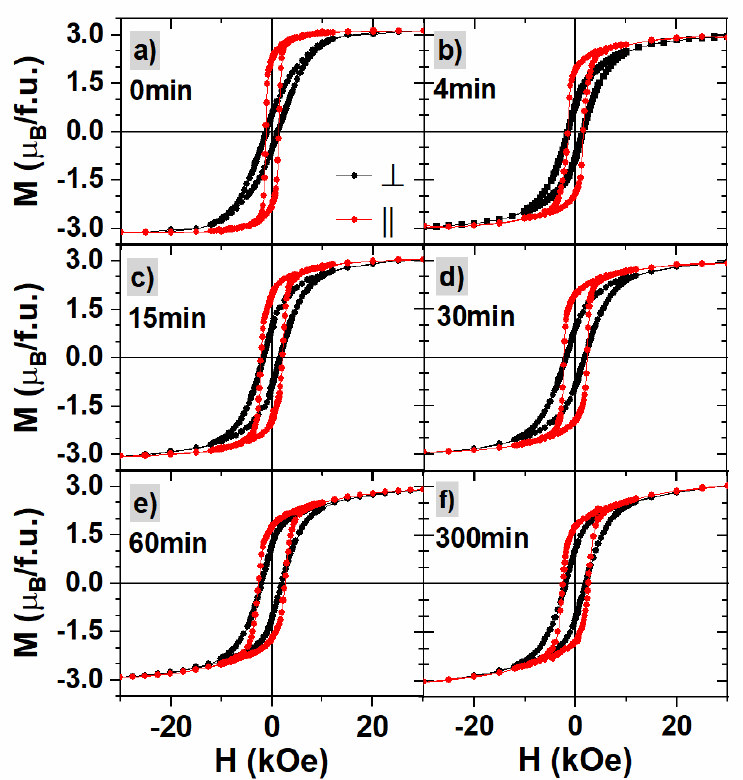
Figure 4. Magnetic hysteresis loops for annealed samples measured with the magnetic field perpen- dicular (black curves) and parallel (red curves) to the sample surface. Graphs ( a – f ) refer to different times of annealing indicated in the left top corner.